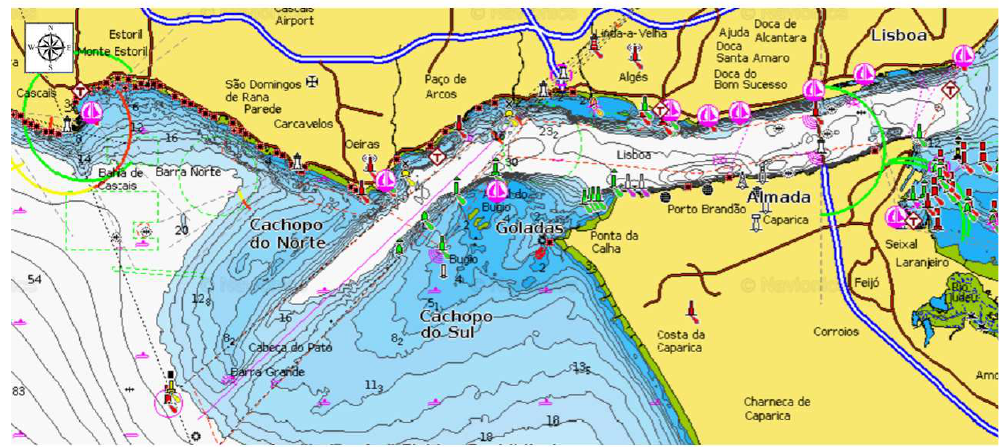
Figure 1. Current cartographic representation of the Tagus estuary (Lisbon, Portugal), showing the ‘Cachopo’ sand banks, the Bugio permanent sand bank as well as the ‘Golada’ channel. Source: www.navionics.com.